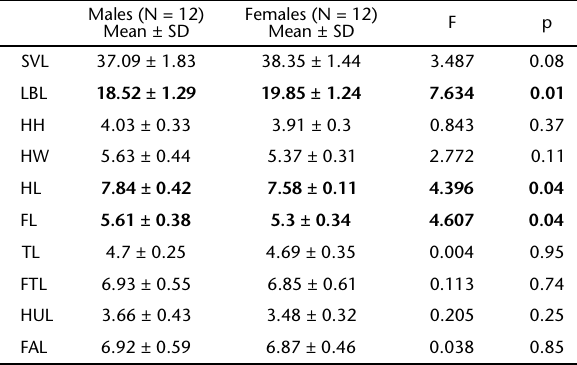
Table II. Morphometric variables with the corresponding mean ± standard deviation and level of significance p from analysis of variance (Anova) for sexual dimorphism. Values with significance < 0.05 are presented in bold. Males (N = 12) Females (N = 12) Mean ± SD Mean ±